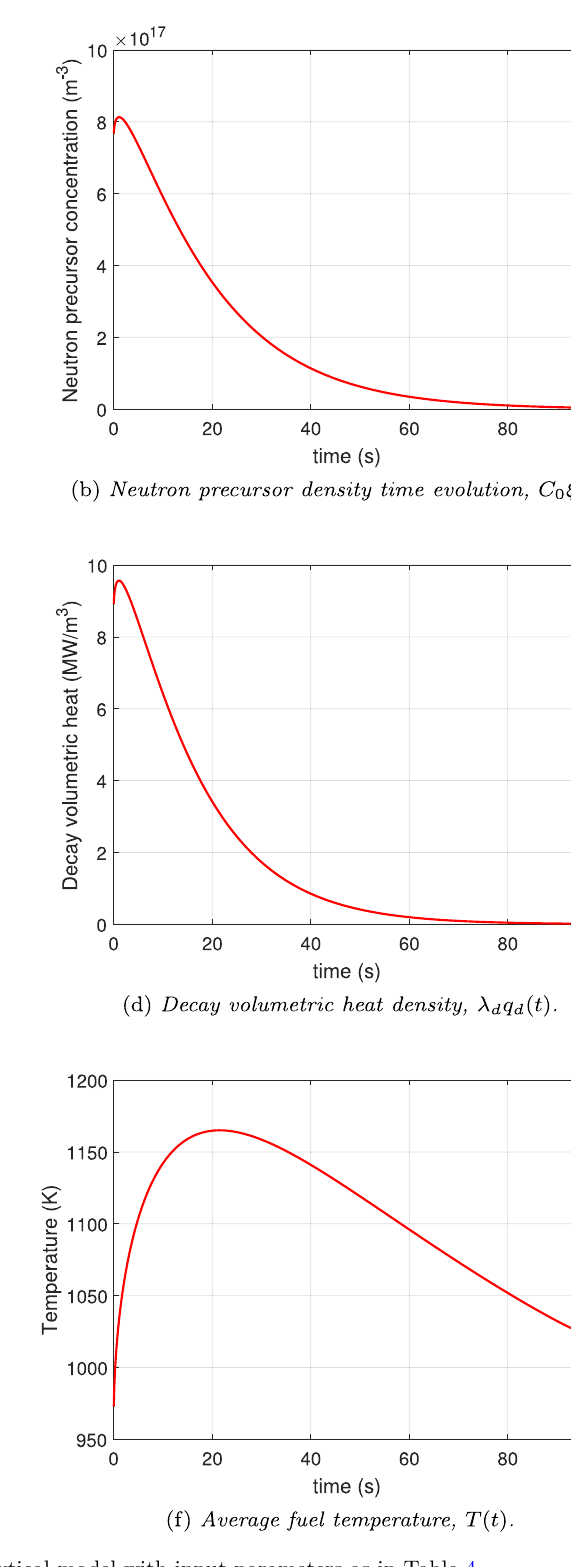
Fig. 7. Simulation results of the 0-D semi-analytical model with input parameters as in Table